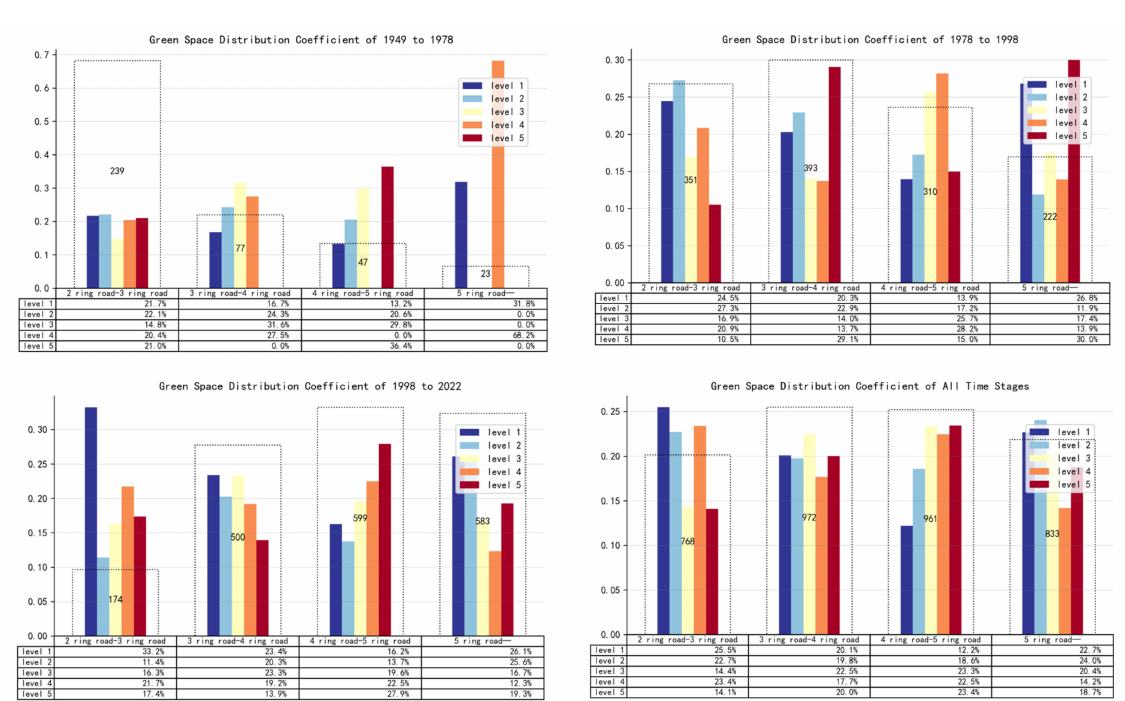
Figure 14. Measurement results of the Green Space Distribution Coefficient